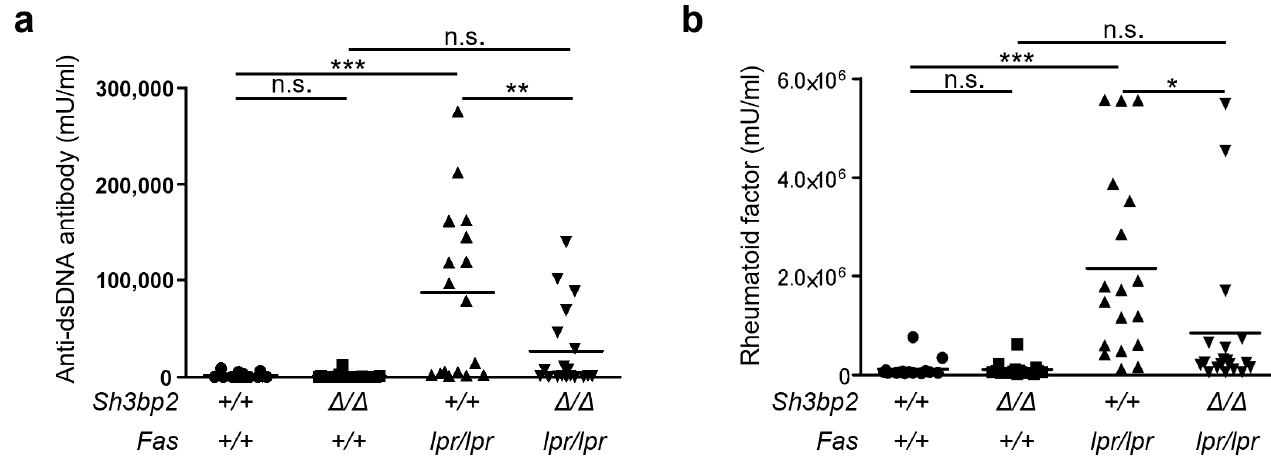
Figure 2. SH3BP2 deficiency suppresses elevated autoantibody production of Fas lpr/lpr lupus-prone mice. Serum samples were collected from Sh3bp2 +/+ ( n = 15), Sh3bp2 ∆ / ∆ ( n = 16), Fas lpr/lpr ( n = 18), and Sh3bp2 ∆ / ∆ Fas lpr/lpr ( n = 19) mice at the age of 35 weeks. Levels of anti-dsDNA antibody (IgG) ( a ) and rheumatoid factor (IgM) ( b ) were determined by ELISA. Each dot denotes an individual mouse, and horizontal lines represent the means. * p < 0.05; ** p < 0.01; *** p < 0.001; n.s.= not significant.